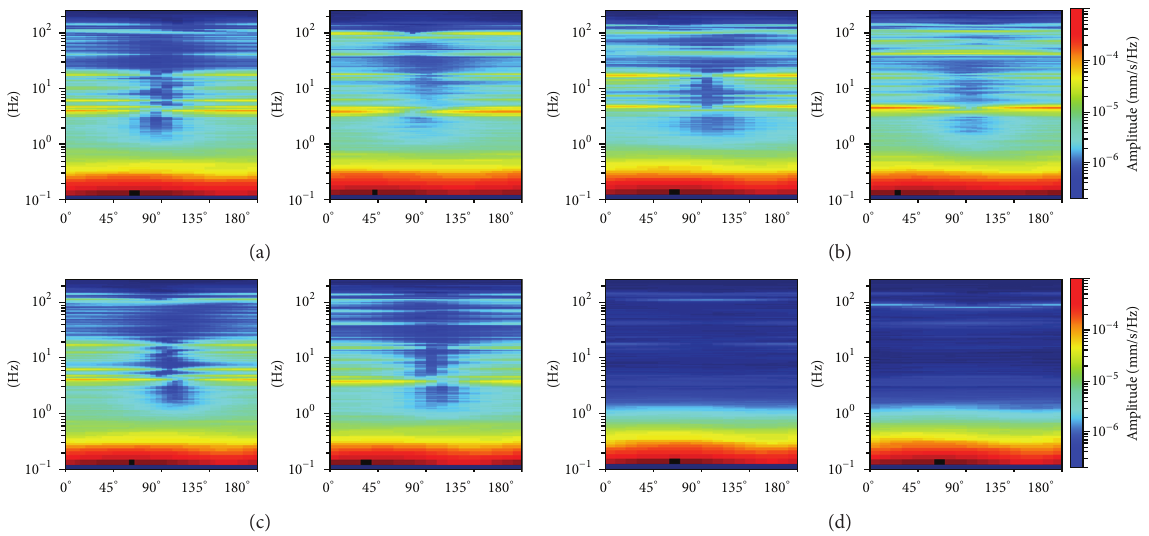
Figure 5: Directional spectra derived for the TR03 (a), TR04 (b), TR05 (c), and TR14 (d) microtremor horizontal traces acquired during both passive